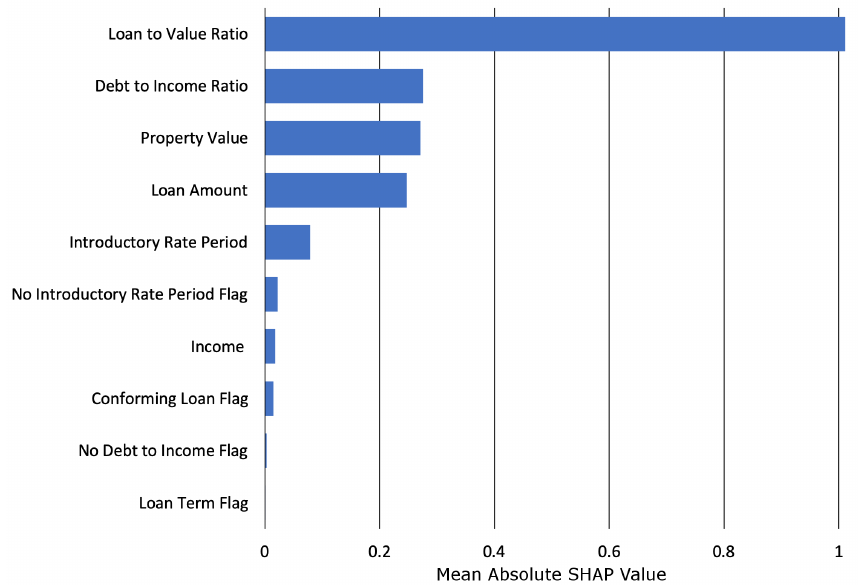
Figure 2. Global mean absolute Tree Shapley Additive Explanations (SHAP) feature importance for g MGBM ( X ) on the mortgage test